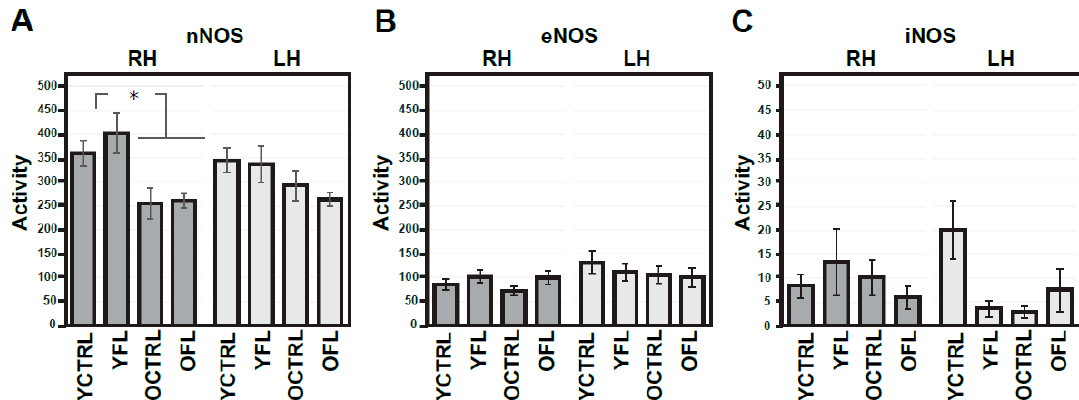
Figure 3. Activities of nitric oxide (NO) synthases in the right and left parietal cortex of young adult and old rats exposed in response to forced locomotion. Activities of various NOS isoforms ( A – C ) are expressed as nmoles / 30 min / mg of proteins. Results are presented as means ± SEM. Statistical significance (Student’s t -test) was calculated with respect to young adult controls (* p < 0.05, ** p < 0.01). RH—right hemisphere, LH—left hemisphere, nNOS—neuronal NOS, eNOS—endothelial NOS, iNOS—inducible NOS, FL—forced locomotion, YCTRL—young adult controls ( n = 8), YFL—young